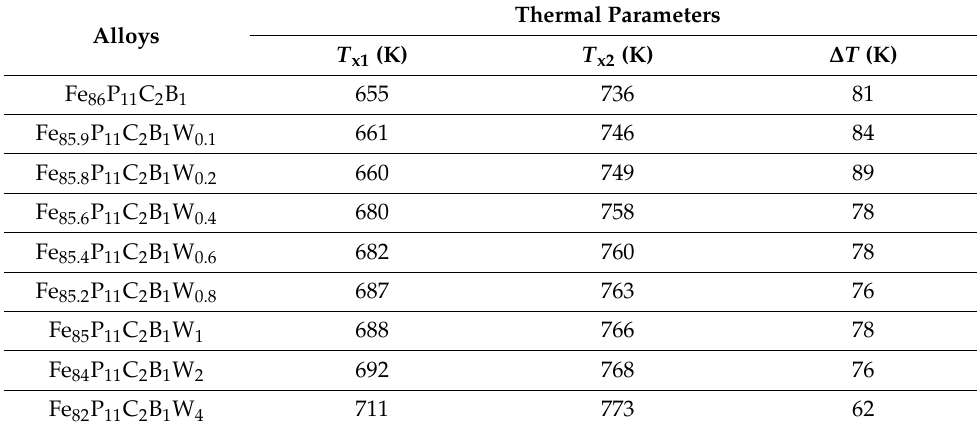
Table 1. Thermal parameters of Fe 86 − x P 11 C 2 B 1 W x amorphous